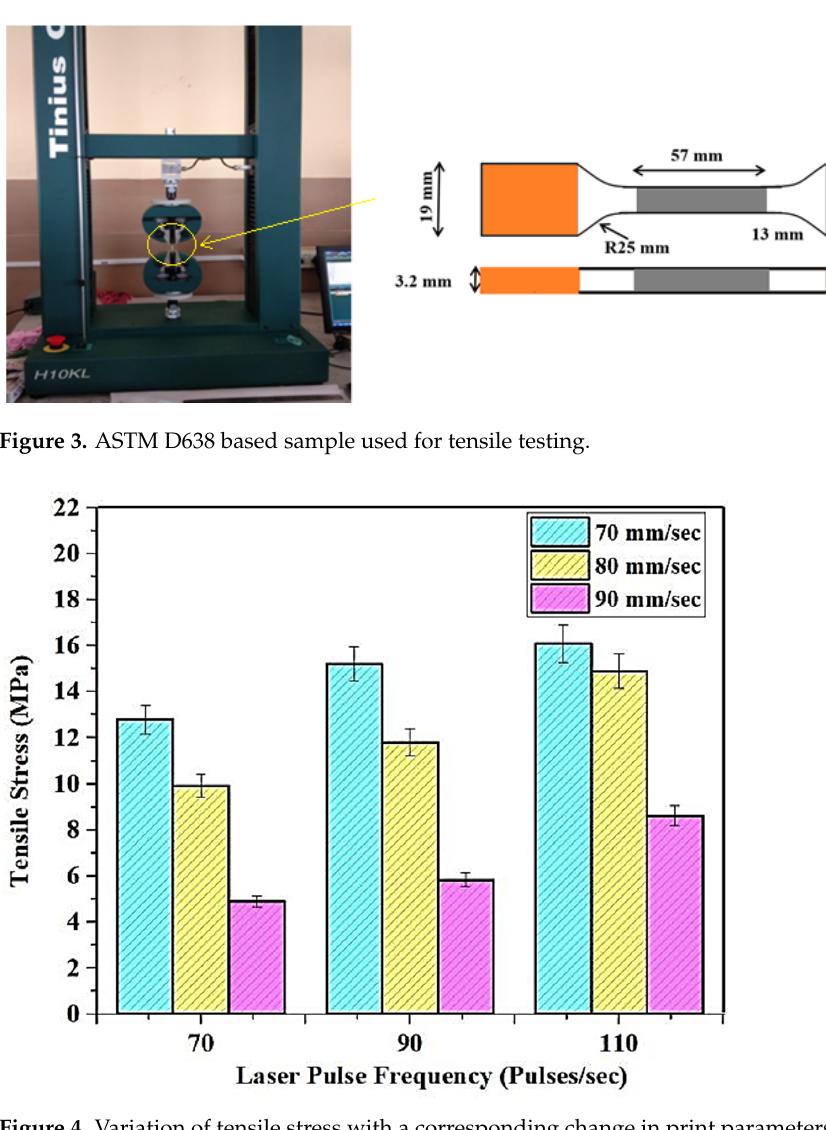
Figure 4. Variation of tensile stress with a corresponding change in print parameters.